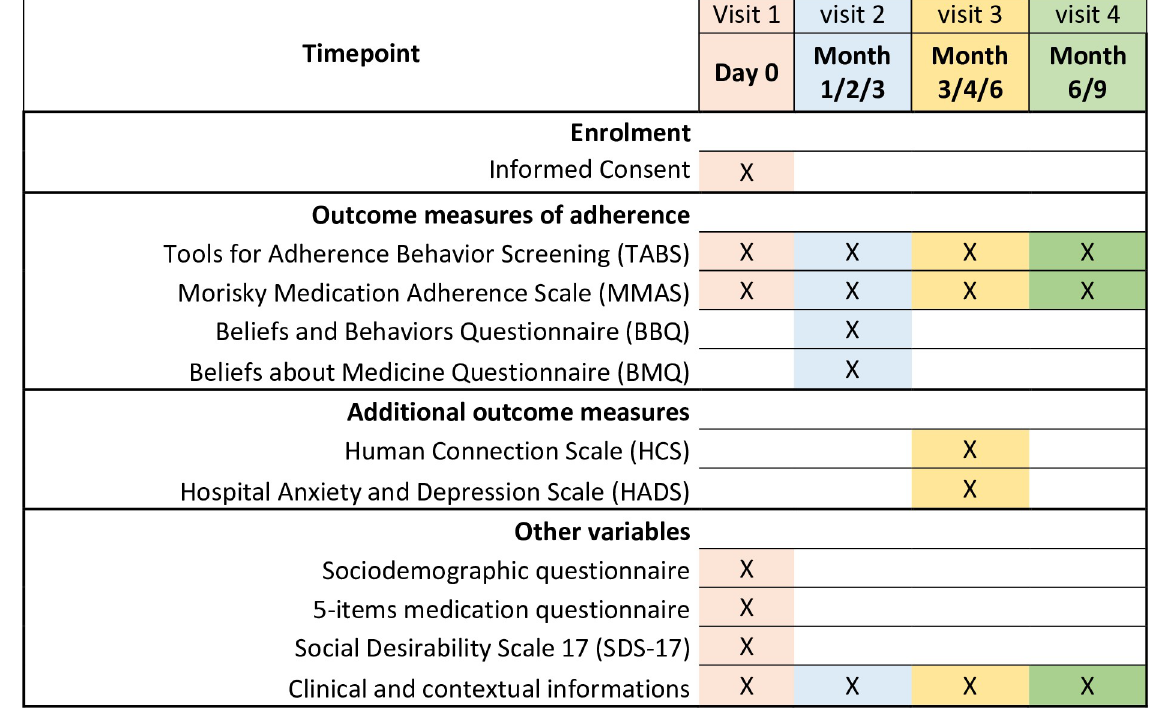
Fig 2. MADESIO questionnaire-based survey participant timeline.